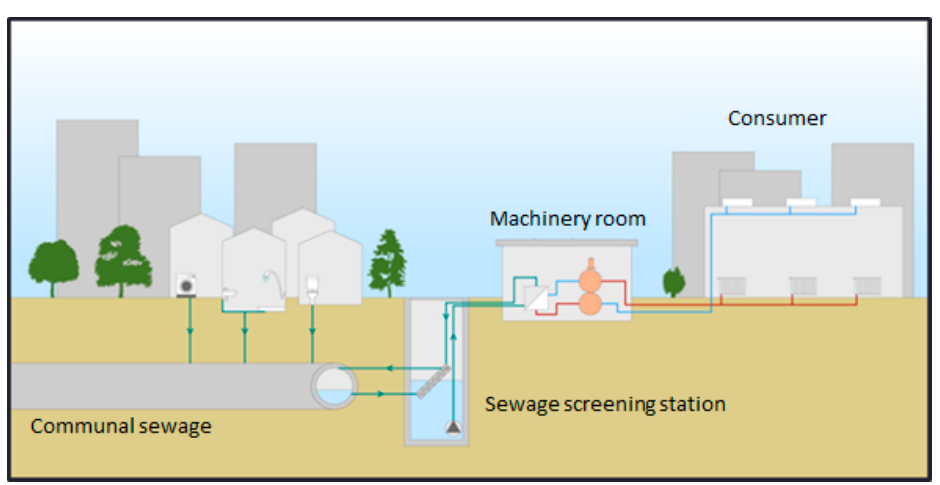
Figure 1. District heating and cooling system using sewage heat recovery.